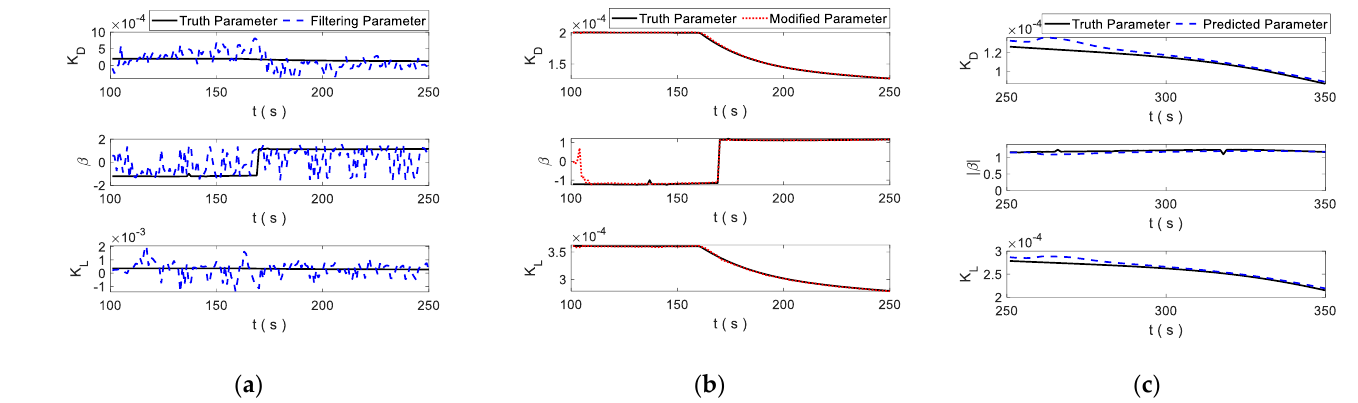
Figure 12. Effect of parameter modification network: ( a ) is the filtering result of the observed control parameters; ( b ) is the modification result of the filtering control parameters; ( c ) is the prediction result of the control parameters values.